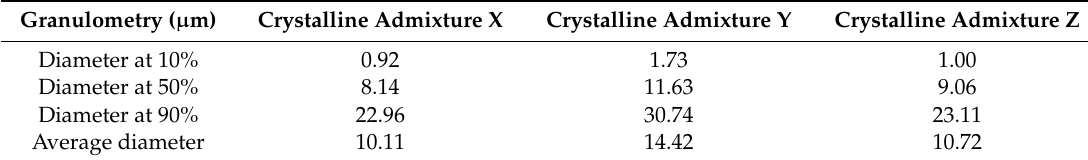
Figure 2. Distribution according to coarse aggregate sieve. Table 2. Laser granulometry of crystalline admixtures.